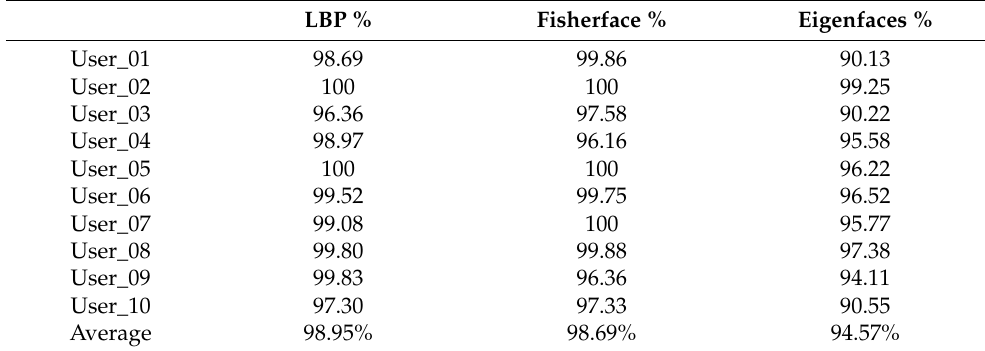
Table 2. The results of the studied face recognition algorithms as percentages.